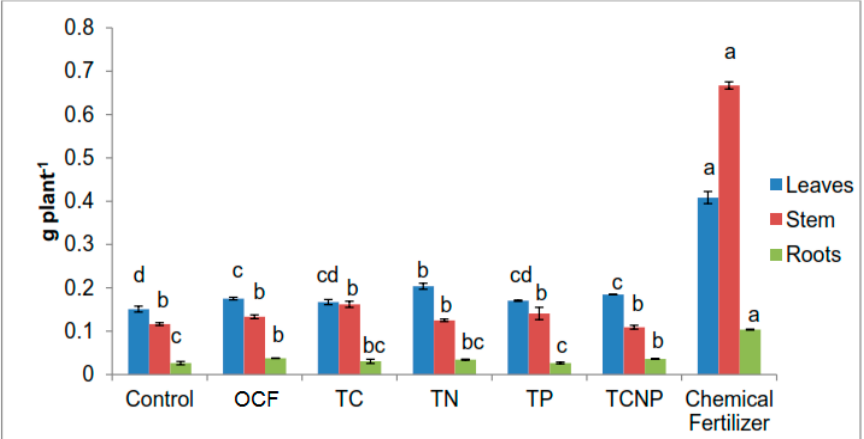
Figure 5. Effect of treatments on potassium uptake in maize plants. Different letters for similar colored bars indicate significant difference between treatment means using Tukey’s test at P ≤ 0.05. Potassium uptake was calculated by multiplying potassium concentration with the dry weight of the respective plant parts.